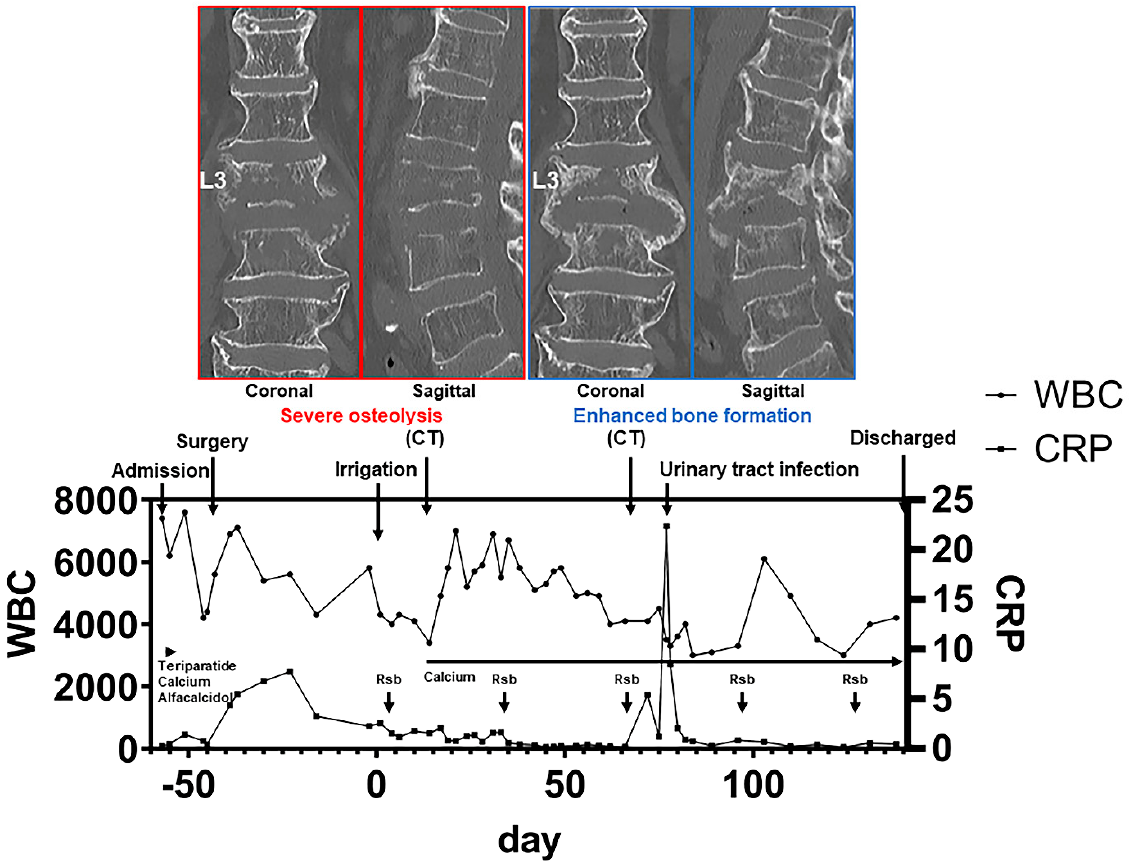
Figure 1. CT images show the severely destroyed osteolytic lesions due to infection and enhanced bone formation at the same site after the administration of romosozumab. The events during hospitalization are illustrated together. Rsb indicates romosozumab subcutaneous injection.